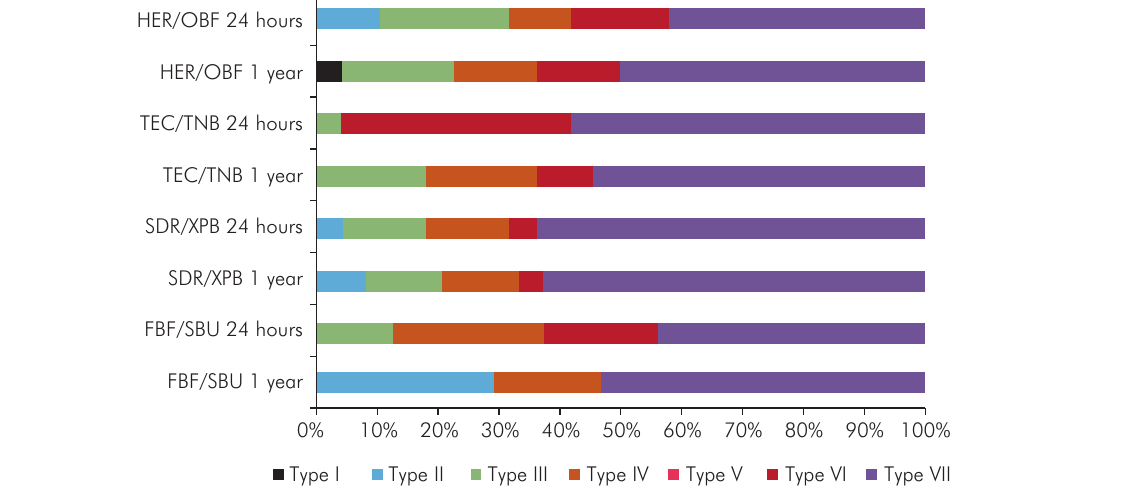
Figure 2. Distribution (%) of failure modes of the restorative systems after 24h and 1y of water storage.